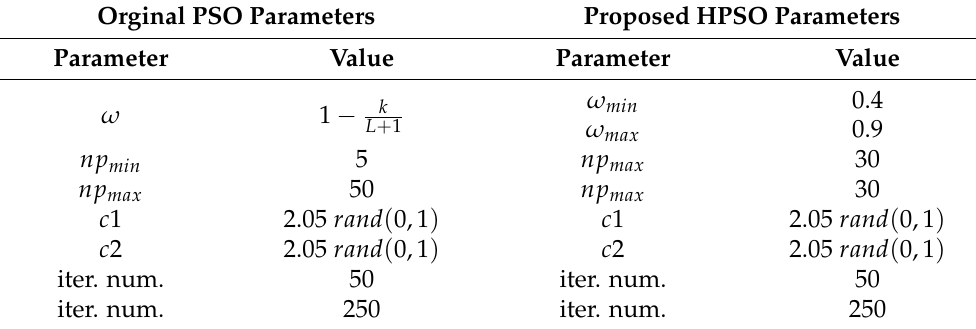
Table 2. Initial configuration for input parameter